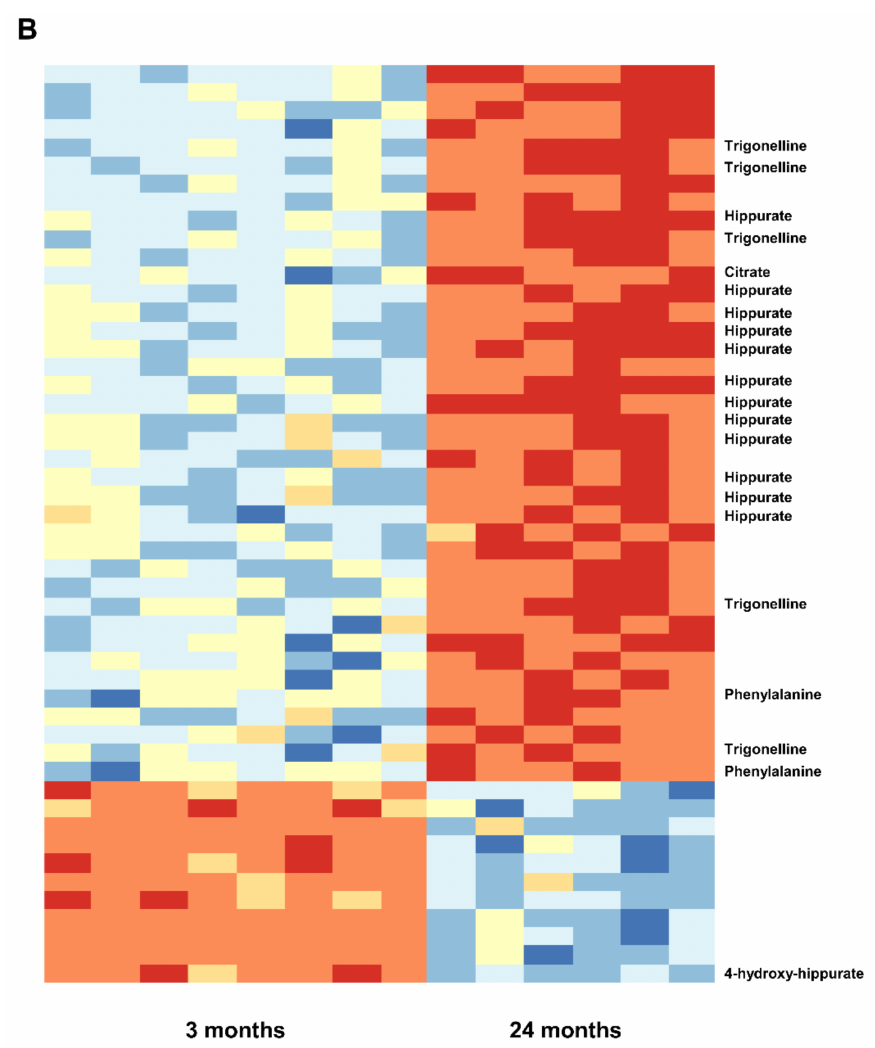
Figure 3. ( A ). Fingerprinting analysis from urine of 3- and 24-month-old rats by 1D 1H NMR spectroscopy. Principal component analysis (PCA). Blue triangels and red dots denote young and old animals, respectively. ( B ). Heatmap of the 50 most regulated features. Metabolites up- and down- regulated relative to their respective means are shown in blue and red, respectively. Samples 1–8 originate from young animals (3 months), while samples 9–14 correspond to old animals (24 months). Metabolites that could be unambiguously assigned to a given feature are